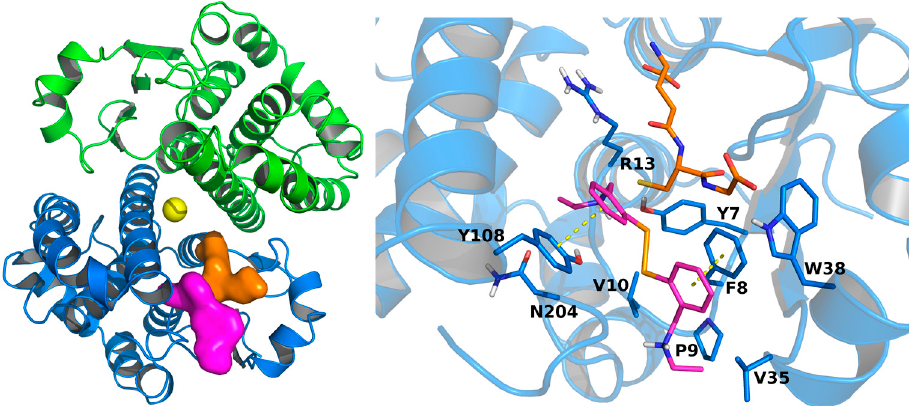
Figure 5. Left , docking-predicted binding site for compound 5 (Magenta surface). GST crystal structure is depicted in blue (chain A) and green (chain B) cartoons. Glutathione (PDB ID: 5DJM) and cis-platin (PDB ID: 1AQW) experimental coordinates are represented in orange and yellow, respectively. Right , docking-predicted bound conformation of compound 5 , in magenta sticks. GST crystal structure is depicted in blue sticks and cartoons. Glutathione experimental bound conformation (PDB ID: 5DJM) is depicted in orange sticks. Potential π – π interactions are represented by yellow dashed lines.